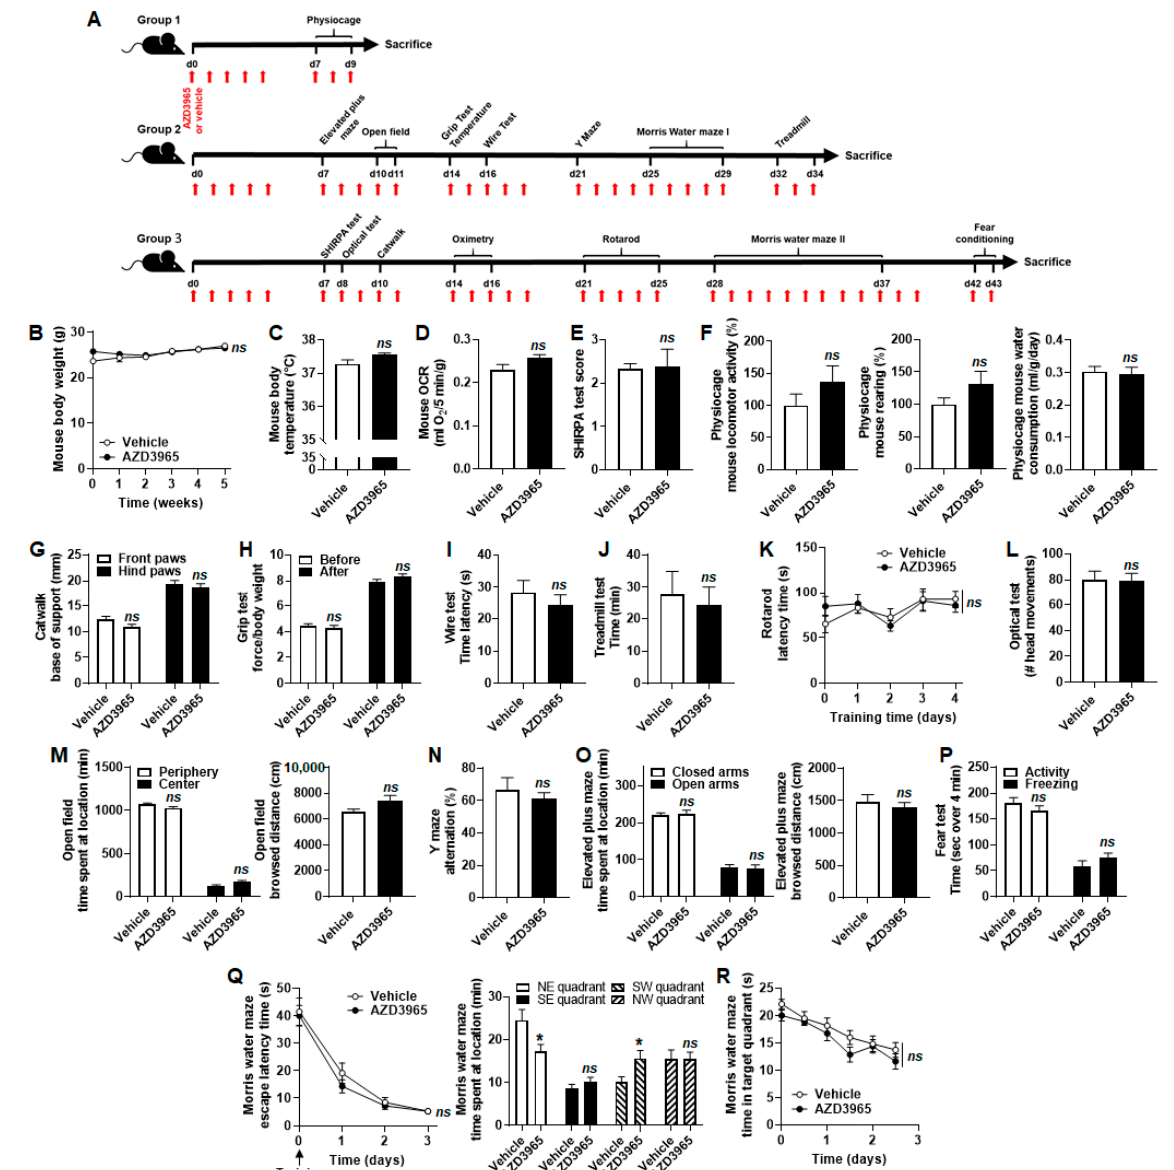
Figure 7. AZD3965 transiently reduces memory retention in mice, preserving other physiological metabolic, muscular and neuronal functions. ( A ) Cartoon depicting the sequence of phenotypic mouse experiments. Red arrows indicate treatment days (100 mg/Kg AZD3965 per os or vehicle). ( B ) Mouse body weight over time ( n = 7–10). ( C ) Mouse body temperature after 15 days of treatment ( n = 9). ( D ) Mouse OCR ( n = 9–10). ( E ) Modified SmithKline Beecham, Harwell, Imperial College, Royal London Hospital, phenotype assessment SHIRPA test score ( n = 9). ( F ) Mouse activity (left panel), rearing (middle panel) and water consumption (right panel) determined in physiocages ( n = 5–6). ( G ) Base of support of the front paws (white columns) and hind paws (black column) in a catwalk assay ( n = 7). ( H ) Grip test force normalized by mouse body weight ( n = 8–11). ( I ) Time spent by mice hanging on a wire ( n = 8–10). ( J ) Time spent by mice on a treadmill ( n = 8–11). ( K ) Effect of daily training on the time spent by mice on a rotarod ( n = 9–10). ( L ) Number of mouse head movements toward a rotating drum in the optical test ( n = 8). ( M ) Exploration time (left graph) and browsed distance (right graph) of mice in open field ( n = 8–11). ( N ) Path alternation on a Y maze ( n = 8–11). ( O ) Time spent in closed and open arms (left graph) and distance browsed by mice (right graph) in an elevated plus maze ( n = 8–11). ( P ) Activity and freezing times of the mice in a fear test ( n = 9–10). ( Q ) Escape latency time (left graph) and time spent in each quadrant on day +3 (right graph) of a Morris water maze. Target quadrant was NE ( n = 8–11). ( R ) Time spent by mice in the target NE quadrant in the absence of the platform ( n = 9–10). All data are shown as means ± SEM. * p < 0.05, ns p > 0.05 compared to vehicle-treated animals; by two-way ANOVA testing the influence of treatments on whole curves ( B , K , Q left, R ) or Student’s t test ( C – J , L – P , Q